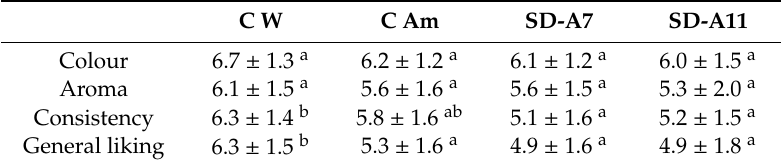
Table 4. Sensory evaluation of breads (mean ± standard deviation). Values were determined with a